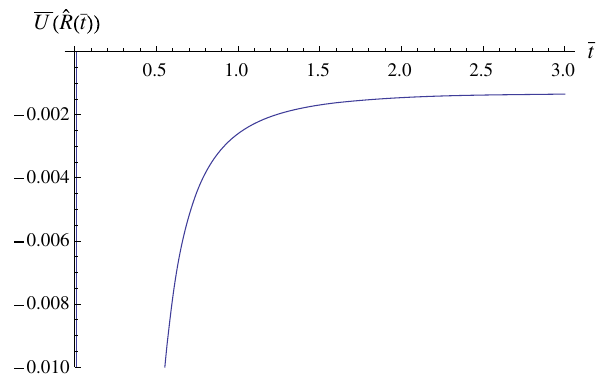
Fig. 14 The evolution of ¯ U ( ˆ R ( ¯ t )) in the Einstein frame in the case when the evolution of the universe starts from the freeze singularity. For illustration it is assumed that f ( ˆ R ) = ˆ R + γ ˆ R 2 + δ ˆ R 3 , where (cid:3) (cid:4) (cid:3) (cid:4) s 2 Mpc 2 s 4 Mpc 4 γ = − 10 − 9 and δ = − 10 − 13 . Time is expressed km 2 km 4 in units of s Mpc and ¯ U ( ˆ R ( ¯ t )) is expressed in units of 10 4 km 2 100 km s 2 Mpc 2